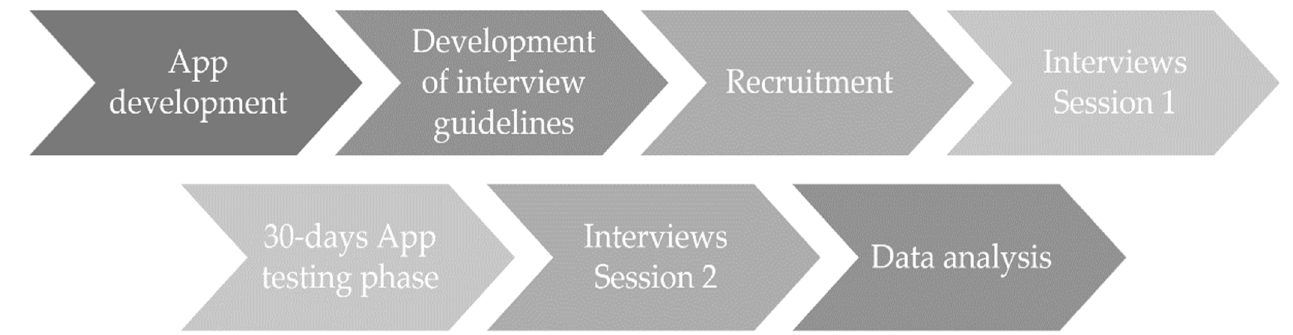
Figure A4. Visual flow of methodology.